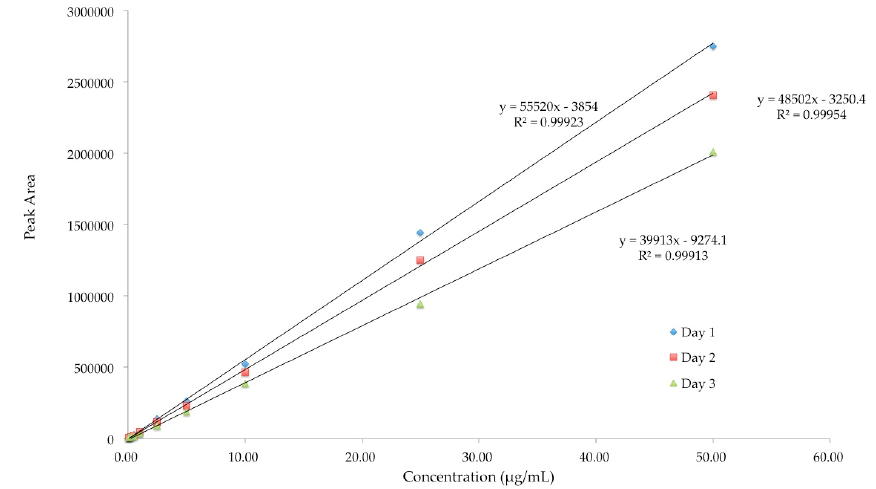
Figure 5. Linearity of HPLC method for analysis of diazepam.